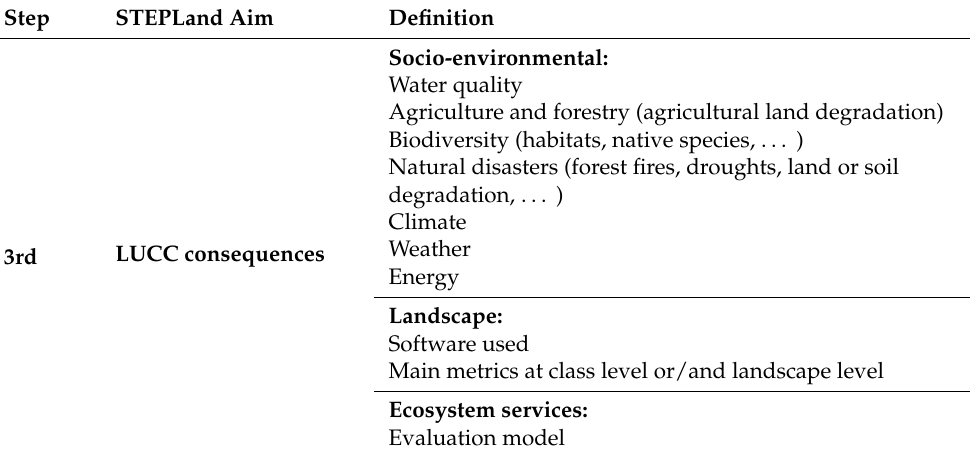
Table 3. Parameters considered in the third step, corresponding to “Socio-environmental conse- quences of